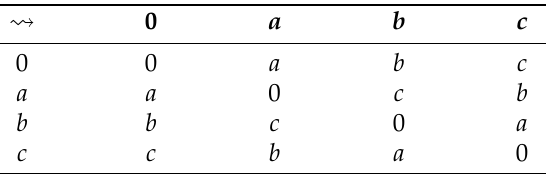
Table 9. Cayley table for the binary operation “ (cid:32)